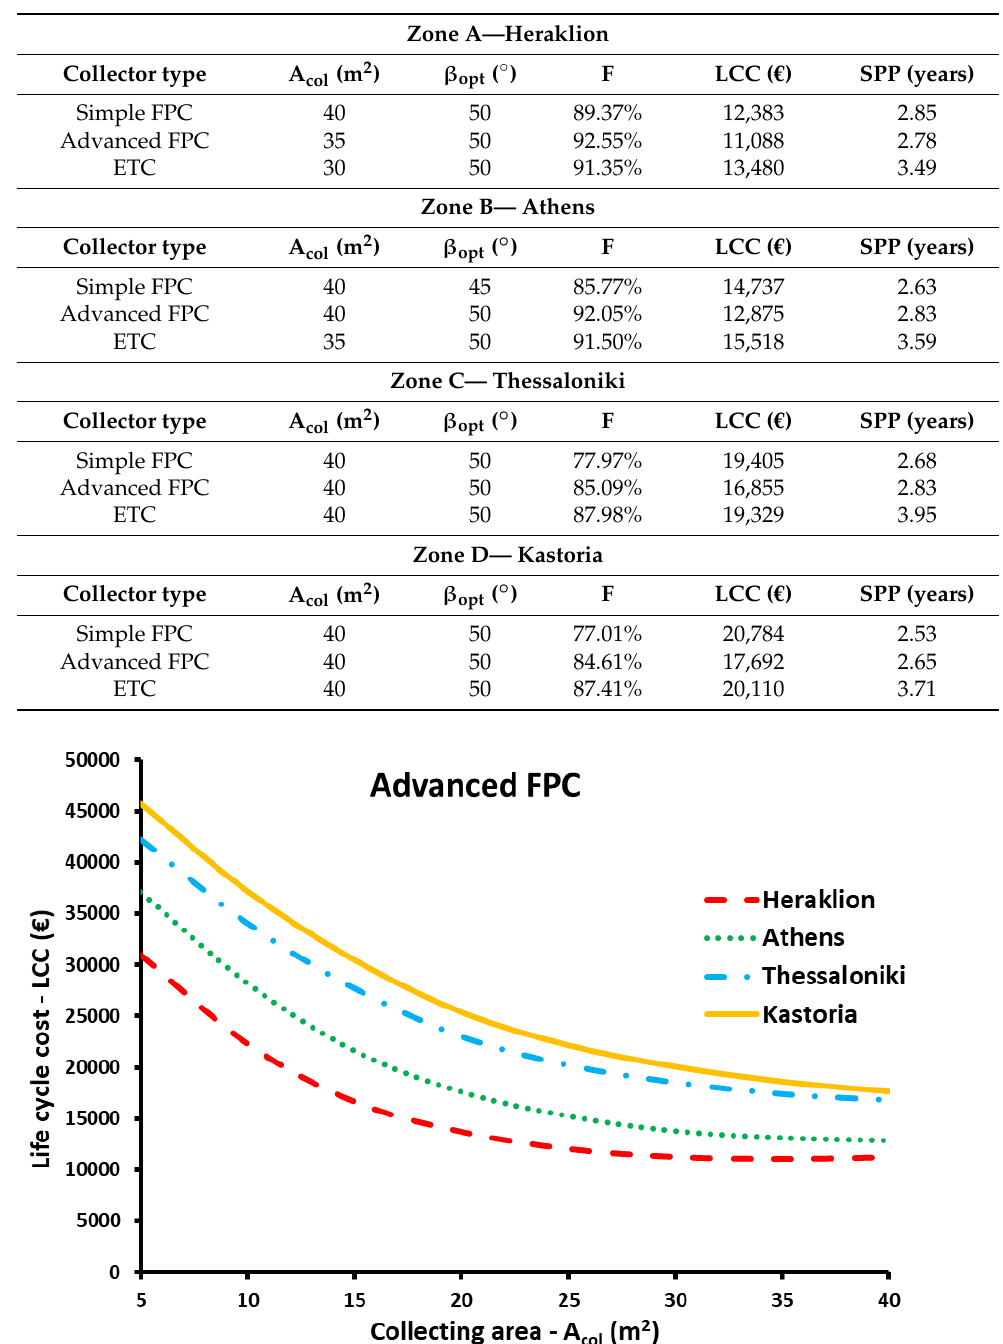
Figure 23. Life cycle cost for different locations with the optimum collector (Advanced FPC).